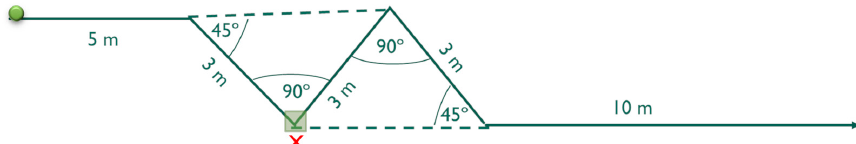
Figure 2. CODAT test diagram. The initial point of the test is drawn with a green ball. The green square shows the location of the force plate. The red cross identifies the change-of-direction task that was recorded with the 3D motion capture system.